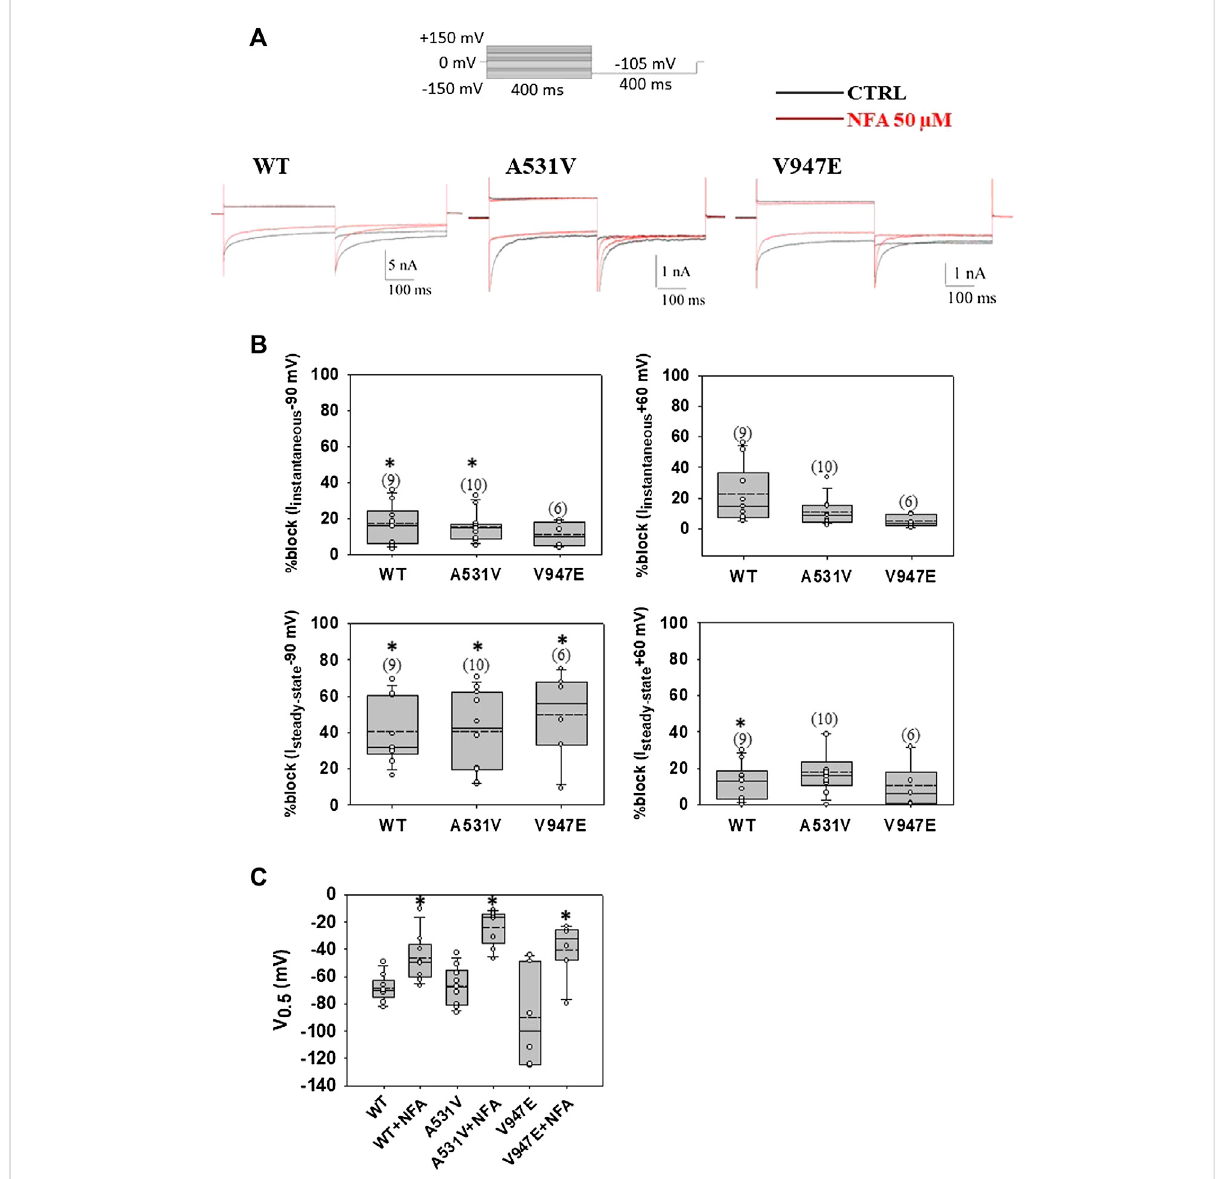
FIGURE 1 Acute application of NFA on WT, A531V, and V947E ClC-1 chloride channels. (A) . Representative traces of WT, A531V, and V947E chloride currents at − 90 and +60 mV before (in black) and after (in red) the application of 50 µM NFA. (B) . Percentage of block of instantaneous and steady- state chloridecurrent for WT,A531V,and V947E mutants measured at − 90 mV and +60 mV induced byNFA 50 µM. (C) . Values of V 0.5 (half-maximal activationpotential)ofWT,A531V,andV947EchannelsbeforeandaftertheapplicationofNFA.EachdotrepresentstheV 0.5 valueobtainedfrom a single recording. Data are shown as box-and-whisker plots. Median (solid line); mean (dash line); and 10th, 25th, 75th, and 90th percentiles are indicated. The number of examined cells is reported in brackets. Asterisk denotes a signi fi cant difference compared with the relative control condition (* p <